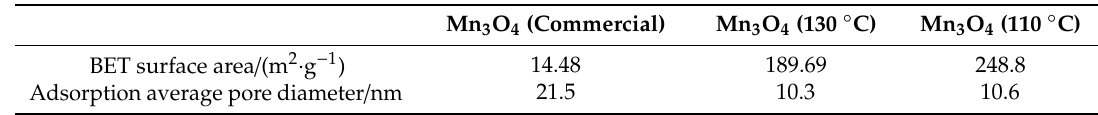
Table 1. BET surface area of Mn 3 O 4 .